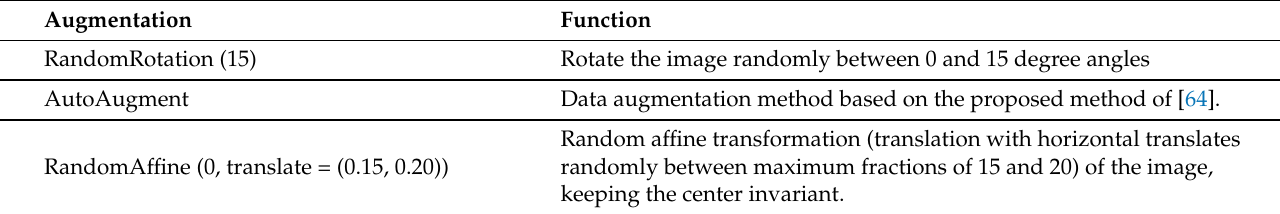
Table 3. The augmentations used before training. In the left column, the transformations applied, and in the right column, the function of the corresponding augmentation.